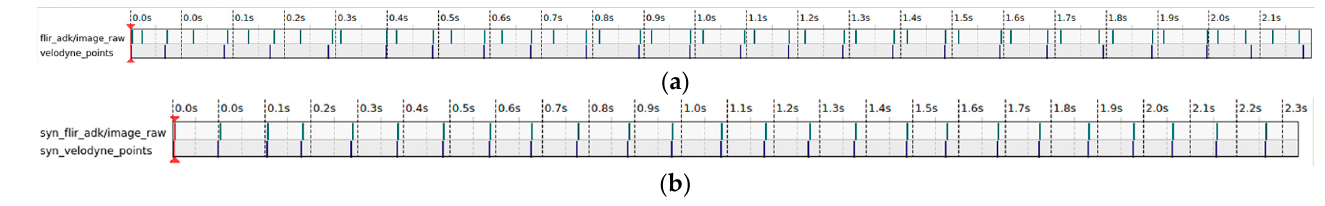
Figure 7. Comparison of the results of multisensor time synchronization: The horizontal axis represents the time, the vertical axis is the sensor topic name, flir_adk/image_raw represents the image data collected by the camera, and velodyne_points represents the point cloud data collected by the LiDAR. ( a ) Unsynchronized multisensor timestamps. ( b ) Synchronized multisensor timestamps.